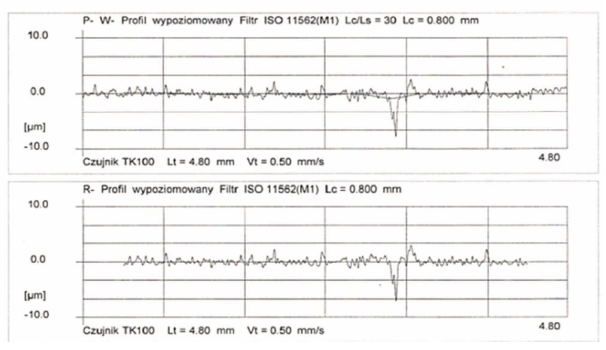
Fig. 9. Cylinder no 1 – wall’s profile